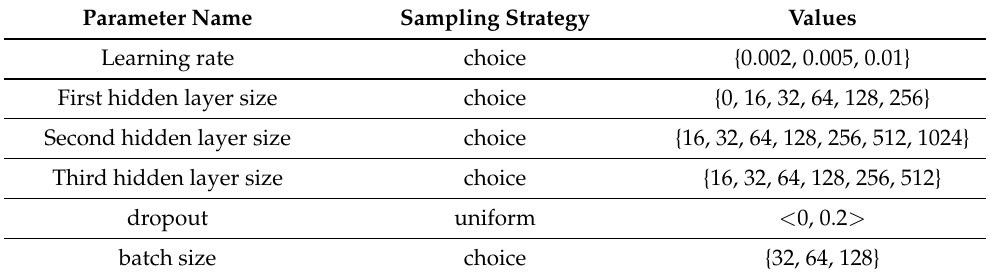
Table 3. Definition of the hyperparameter search space for building an on-device neural network model.